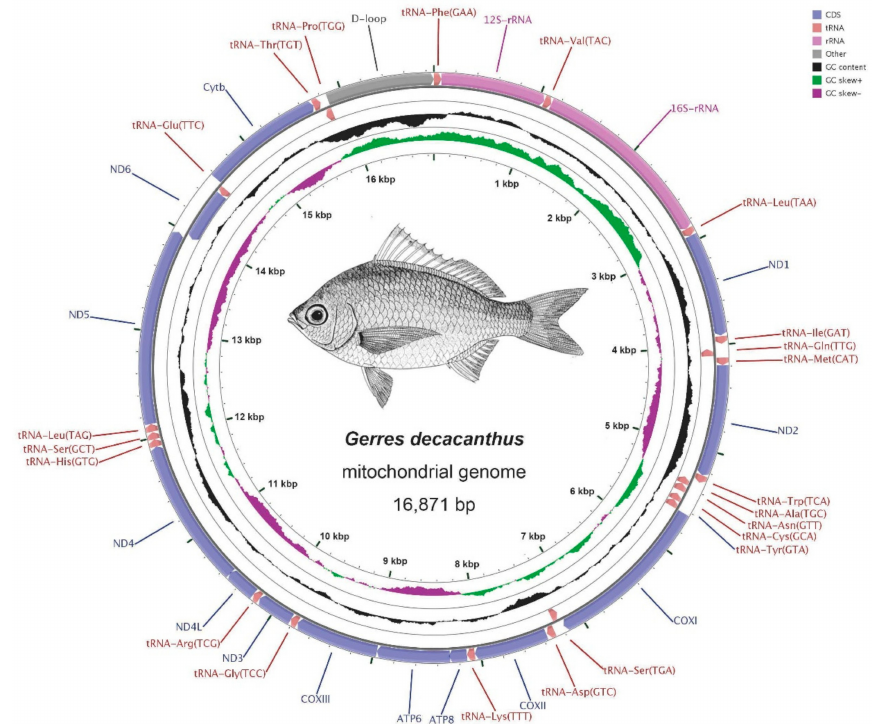
Figure 1. Circular map of the mitogenome of G. decacanthus , G. erythrourus , and G. filamentosus . Genes encoded on the heavy or light strands are shown outside or inside the circular gene map, respectively. The GC content of each gene varied from 30.43% to 60.56%, and the highest was found in tRNA-Trp of G. decacanthus . In addition, the richest AT content regions were detected in the D-loop of G. filamentosus , tRNA-Arg of G. erythrourus , and tRNA-His of G. decacanthus , respectively (Table 1). The entire base composition of the three mitogenomes in H-strand was similar with AT content varied from 52.83% to 53.71% (Table 2). The G content of the three species was low with an obvious bias against G. Besides, the content of A and C exhibited high values at the third codon position, indicating that the codon usage preferred A and C at this position (Table 2). The content of T was the highest in the second codon position, which might be the reason of hydrophobic nature of the proteins